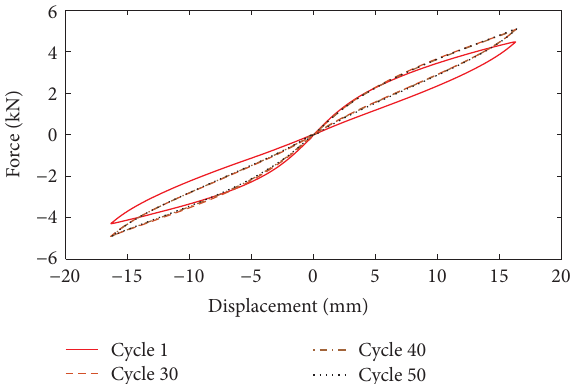
Figure 4: Hysteresis loops at different loading cycles.